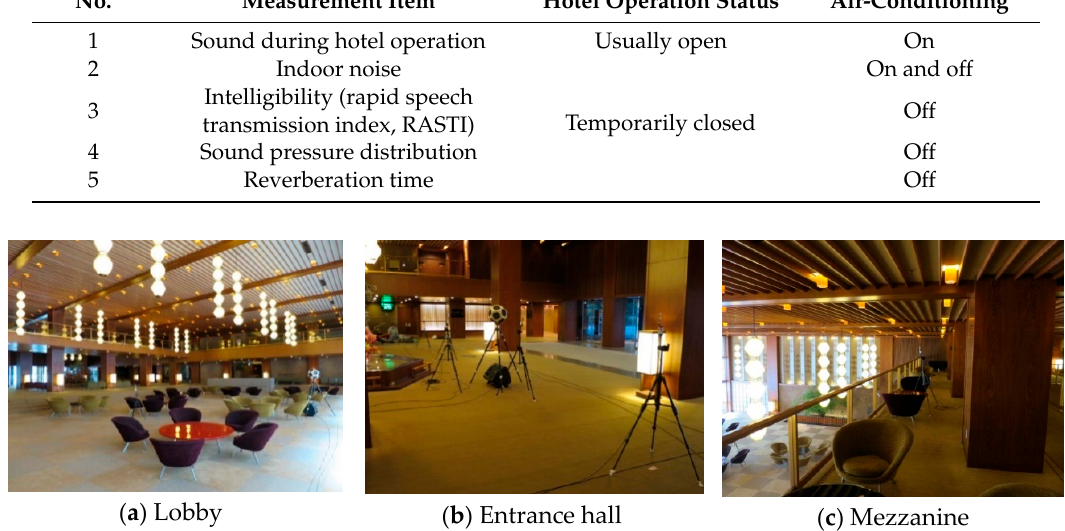
Figure 1. Room conditions during the survey of ( a ) the lobby, ( b ) entrance hall, and ( c ) mezzanine. The table, sofa, and other fixtures were located in the same positions as when normally open.